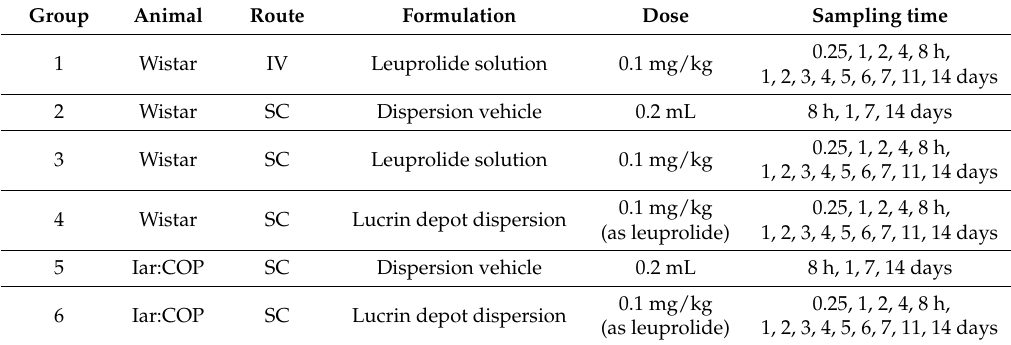
0.25, 1, 2, 4, 8 h, 1, 2, 3, 4, 5, 6, 7, 11, 14 days